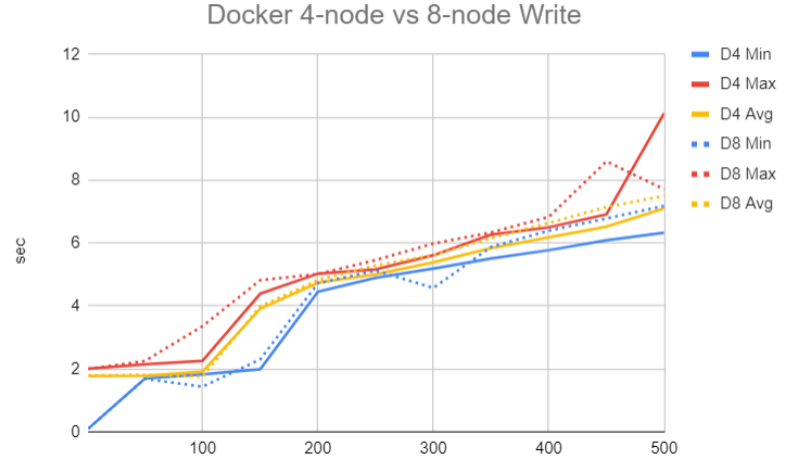
Figure 4. Latency of write TXs (in seconds) measured with a local Indy-based BC and different arrival rates (1–500).